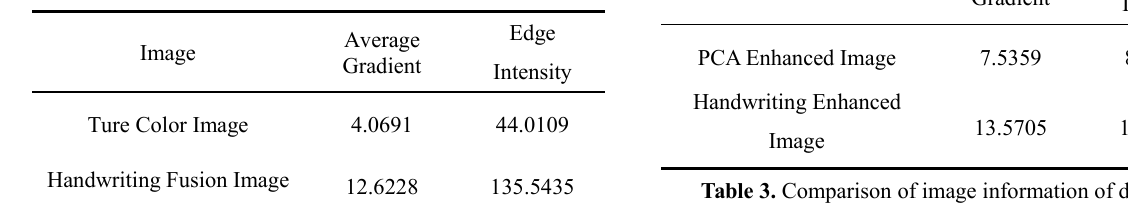
Table 3. Comparison of image information of different